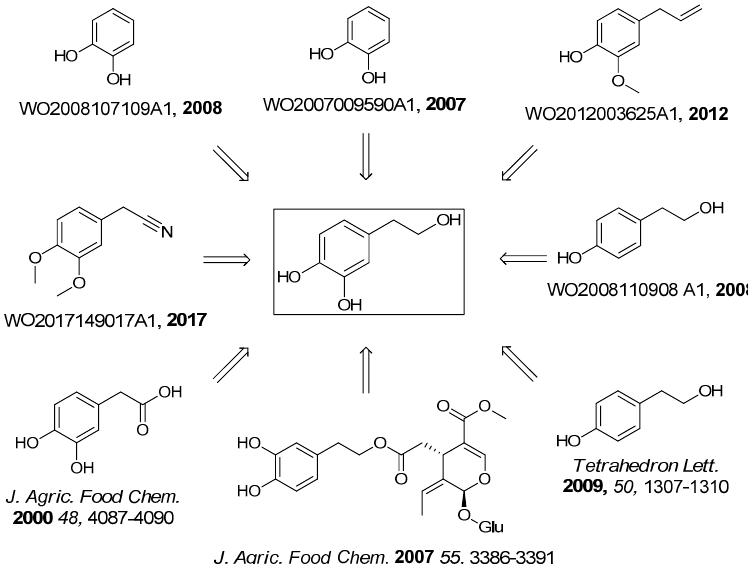
Figure 2. Synthetic approaches for hydroxytyrosol.